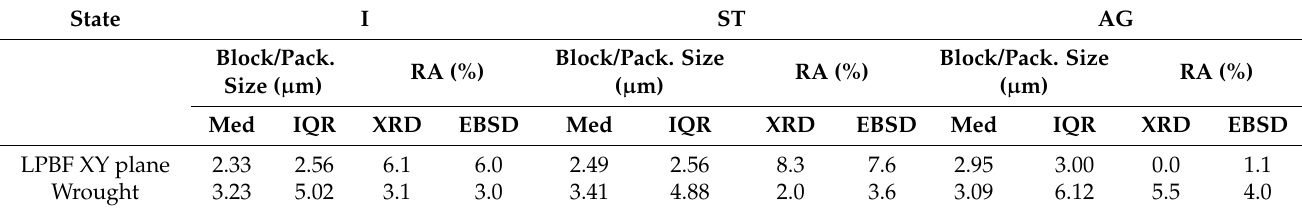
Table 8. Measured block/packet size and RA of the LPBF and the wrought alloys at different processing states. State I ST AG